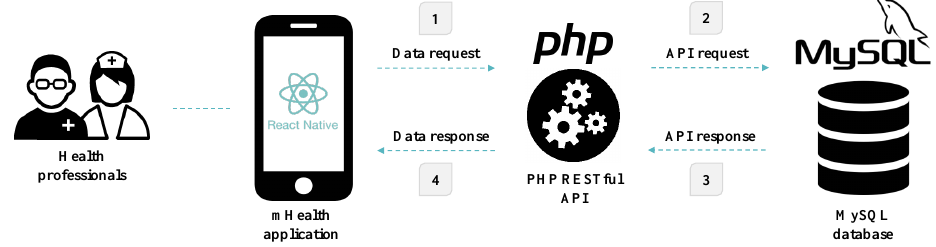
Figure 3. Schematic illustration of the architecture of the mobile